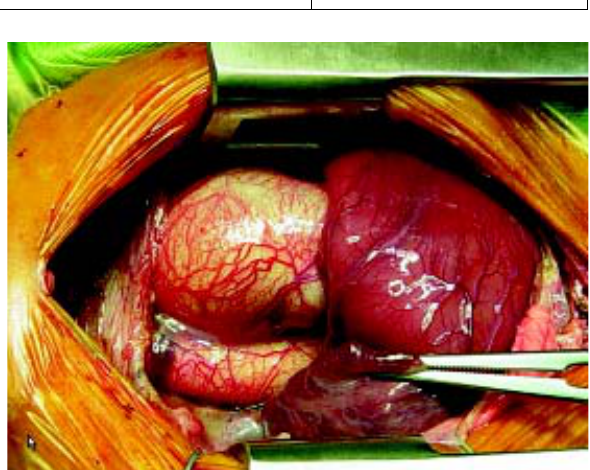
Fig. 1 – Aspecto intra-operatório demonstrando o grande aumento volumétrico das cavidades direitas e tronco da artéria